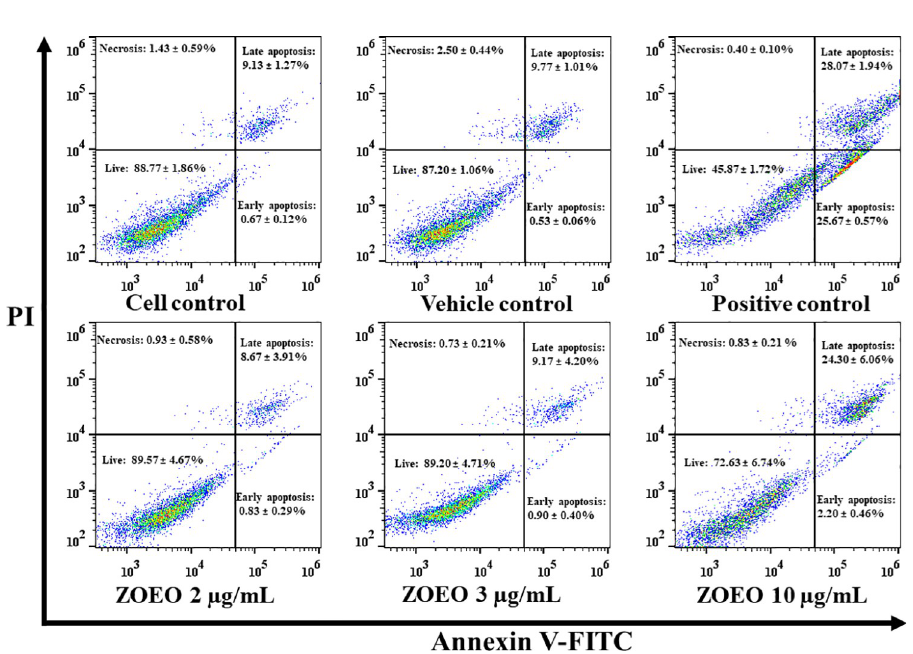
Fig 5. Apoptosis assay by flow cytometry after staining with double annexin V-FITC/propidium iodide (PI). MCF-7 cells were treated with ZOEO at the concentrations of 2, 3, and 10 μ g/mL. Representative flow cytometry dot plot indicating the cell population in apoptotic and necrotic quadrants after treatment with various concentrations. The dataset is available in S7 Table.